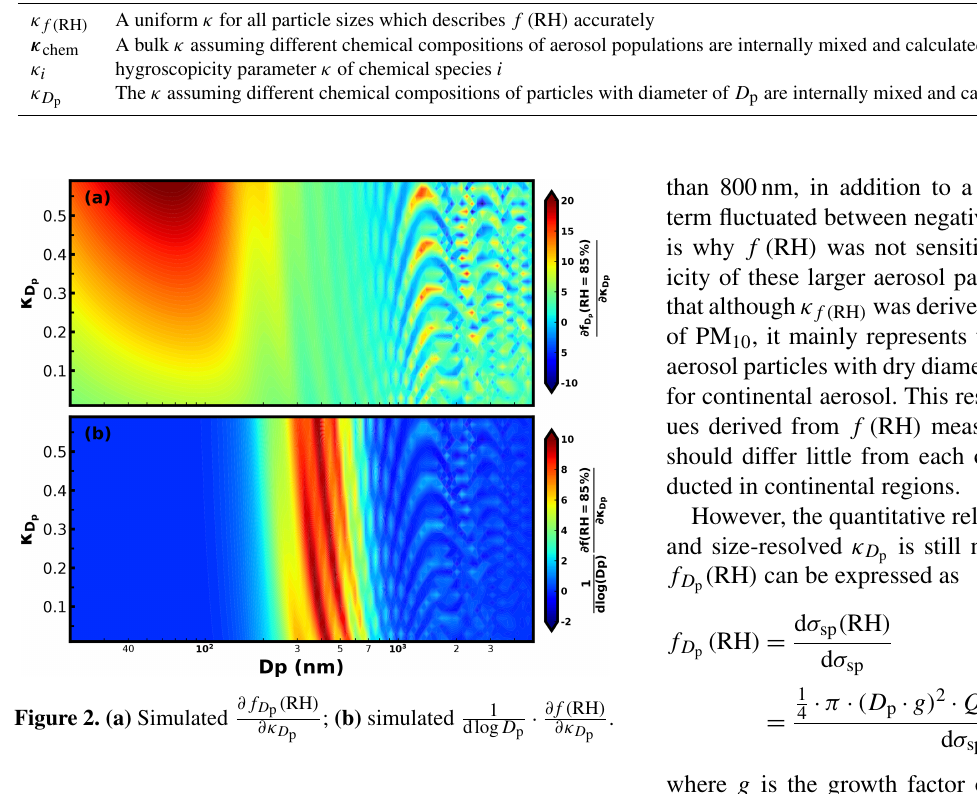
Figure 2. (a) Simulated